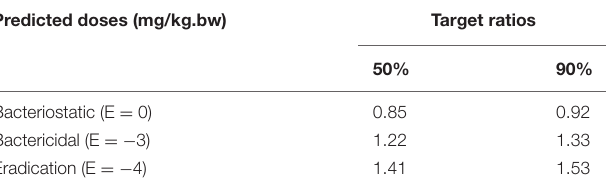
TABLE 4 | The predicted daily doses of MBF curing E.